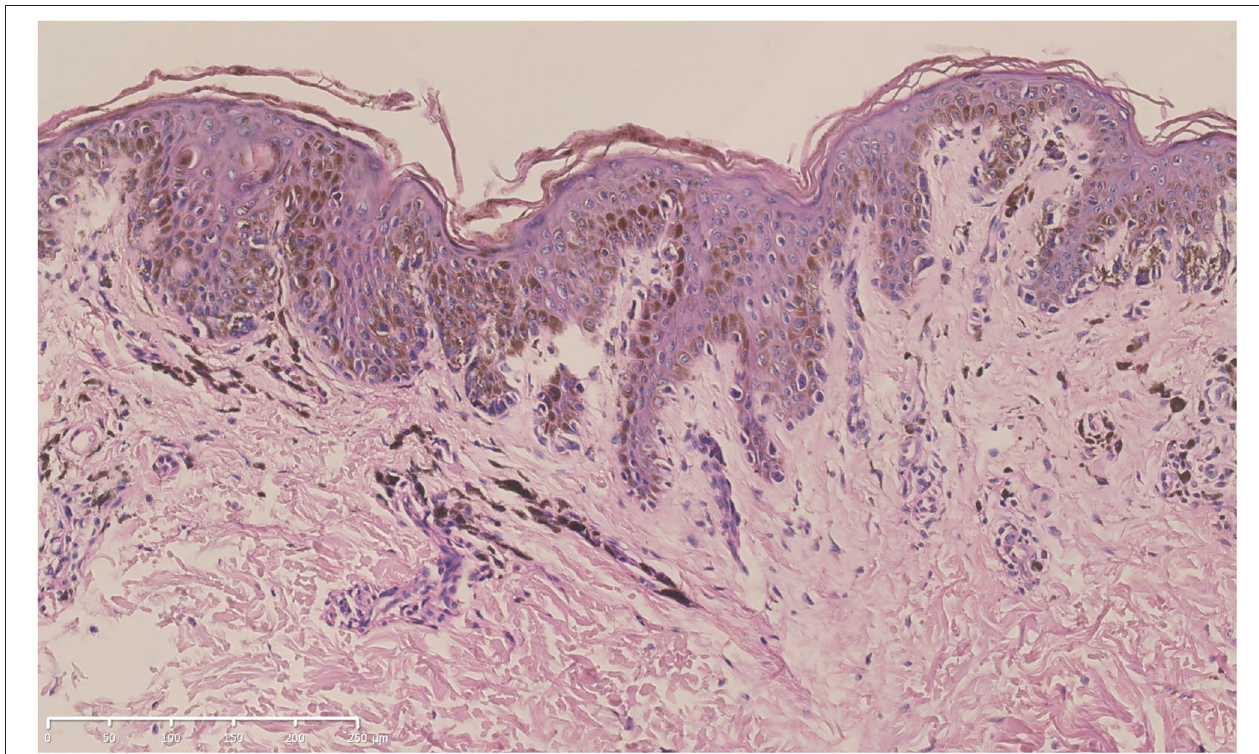
FIGURE 3 | Hematoxylin-eosin staining of the biopsy specimen from the proband (bar = 250 µ m ). Increased melanin production from the basal layer to the spinous layer of the epidermis, lentiginous hyperplasia of melanocytes along the basal layer, and melanophages in the superficial dermis could be seen.